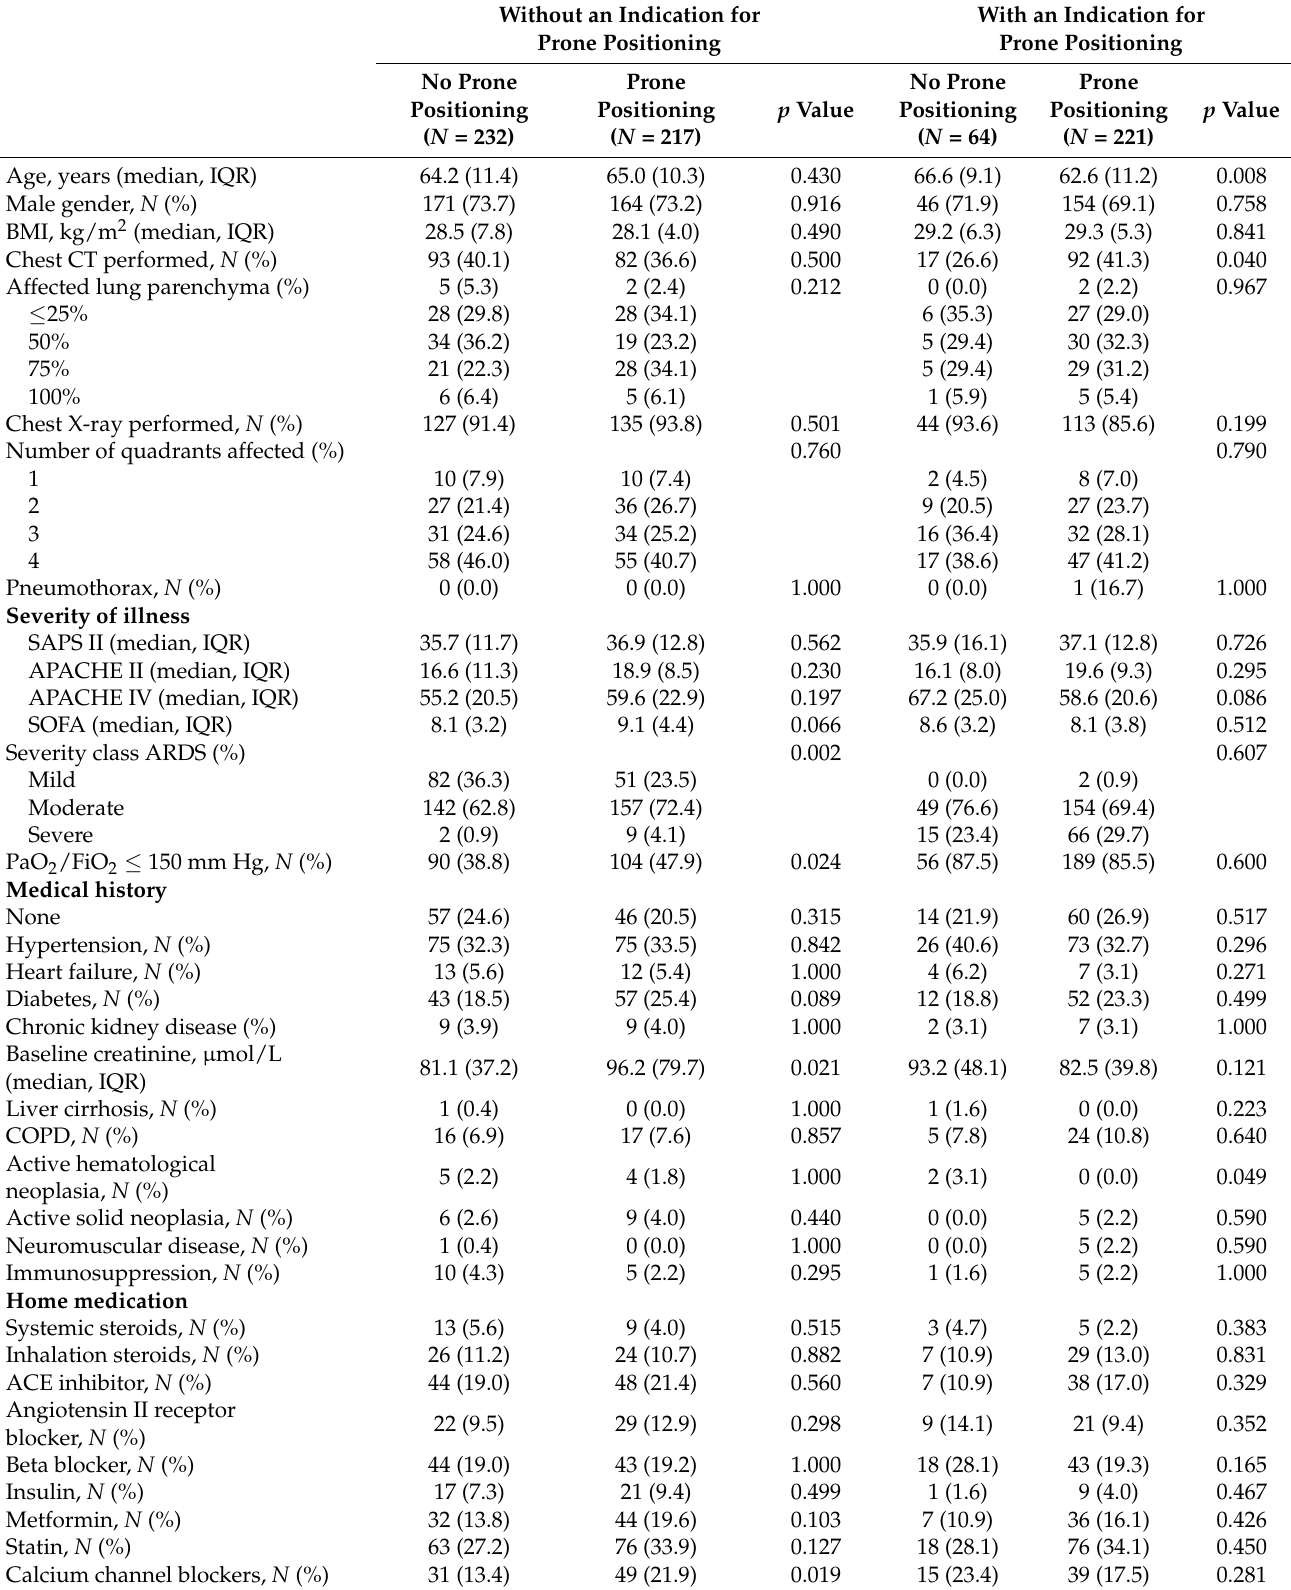
Table 1. Baseline